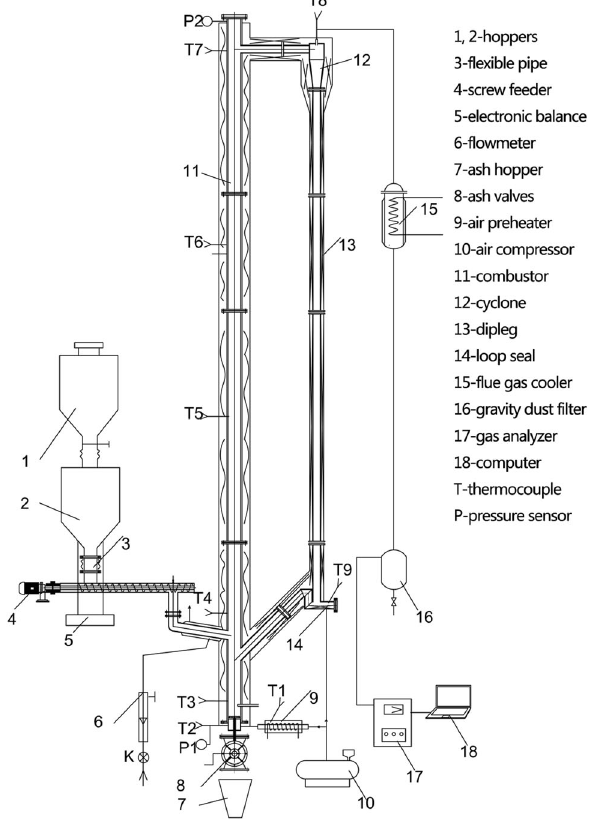
Fig. 1 Schematic diagram of the experimental